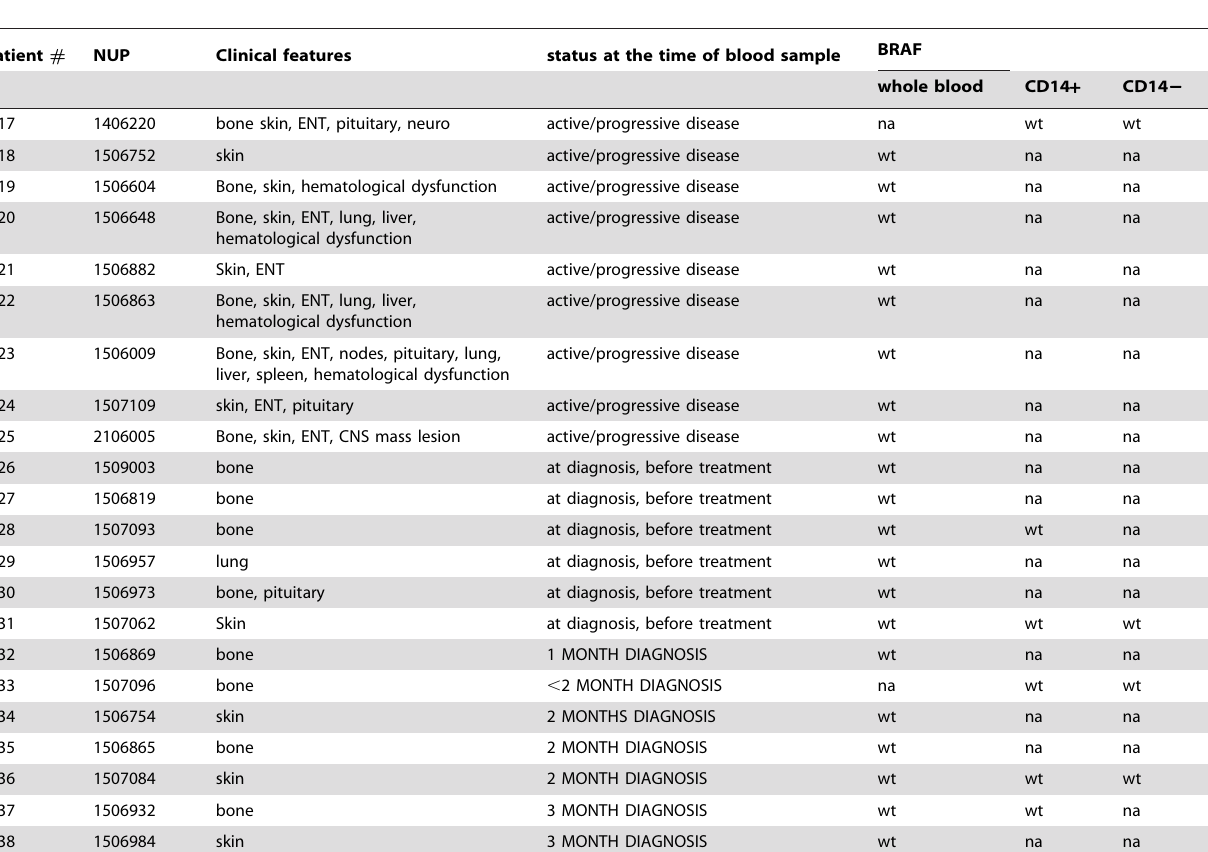
Table 3. Age, sex, clinical features, and molecular findings in 22 patients with available blood samples at the time of diagnosis or